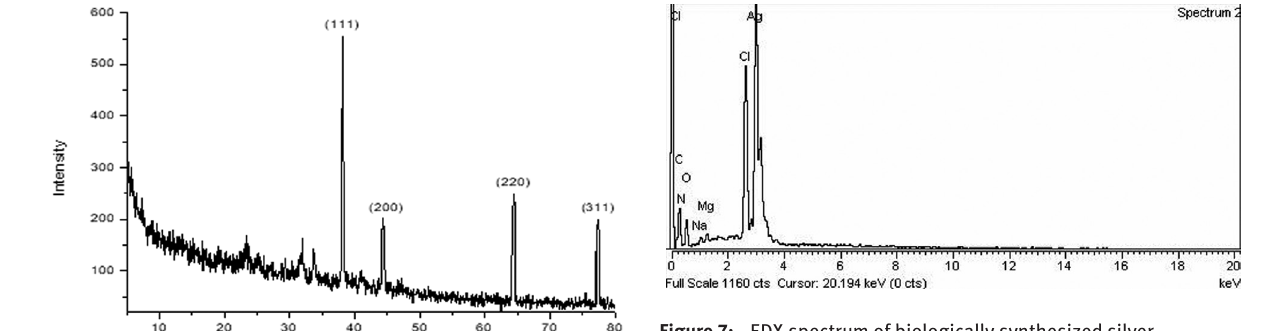
Figure 7: EDX spectrum of biologically synthesized silver nanoparticles by Diospyros lotus .